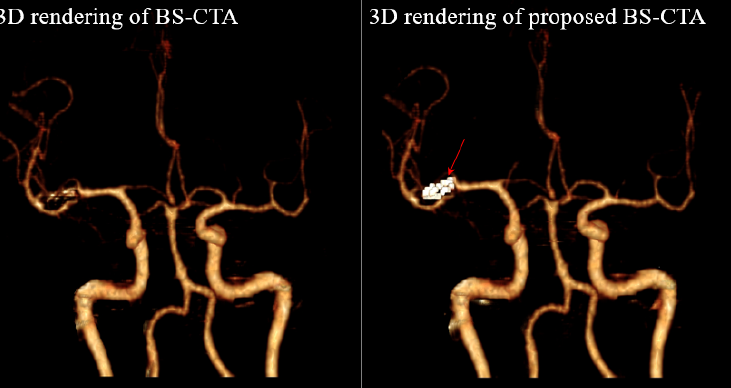
Figure 6. Results of 3D rendering of conventional BS ‐ CTA ( left ) and proposed BS ‐ CTA ( right ).